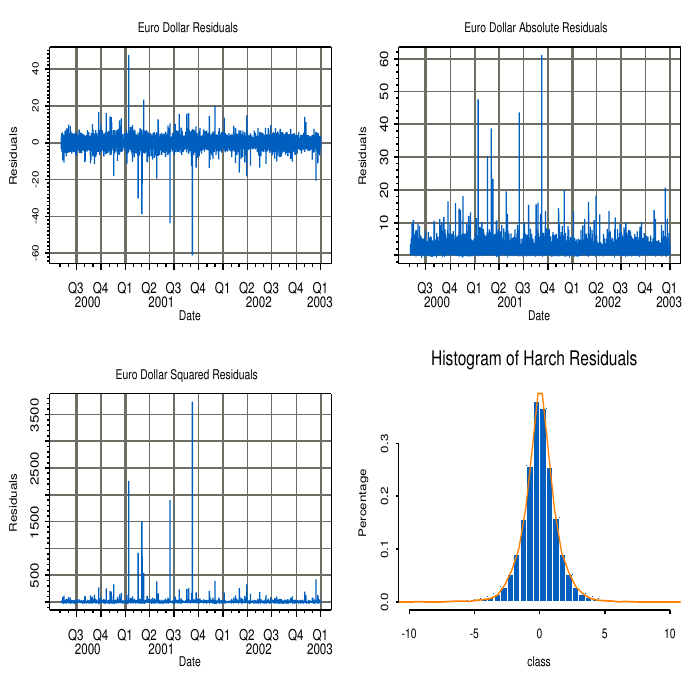
Figure 10. Euro-Dollar residuals, absolute residuals, squared residuals and histogram of the residuals after fitting a PHARCH